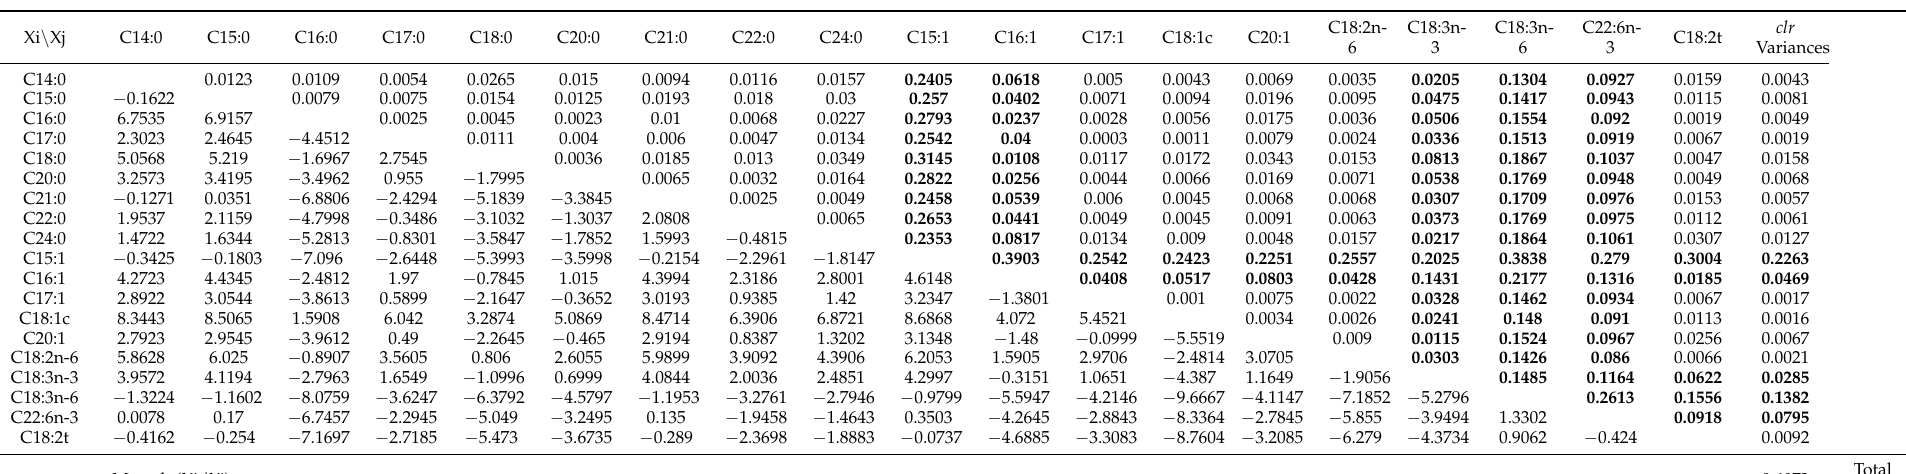
Table 4. Variation array matrix (upper half) and mean log-ratio (bottom half). The clr and total variances ( clr variances sums) are shown in the last column on the right. In bold, the most relevant